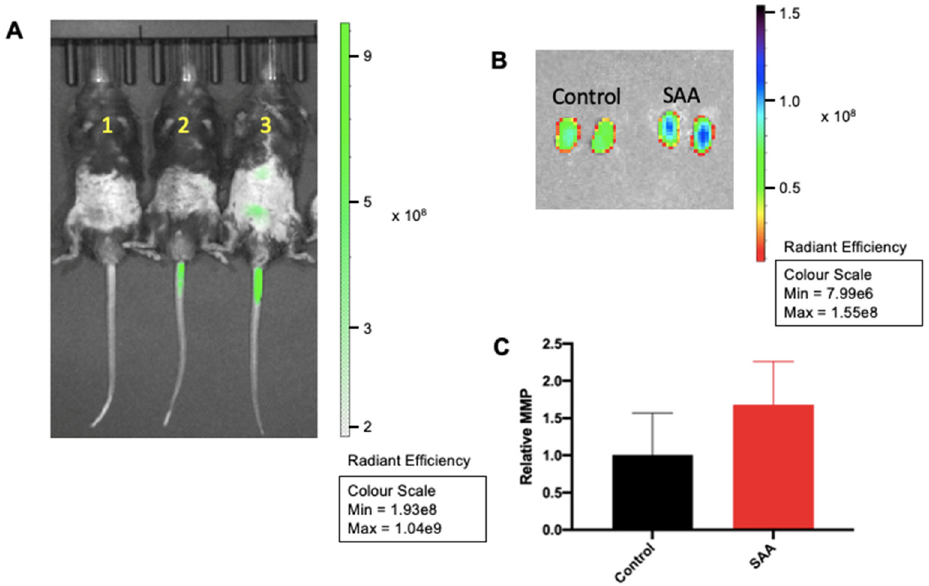
Figure 2. SAA administration activates MMPsense activity in vivo. Male ApoE − / − mice were randomly allocated to vehicle control (administered 100 µL PBS every 3 days for 2 weeks) and the SAA group (administered 12 µg SAA protein every 3 days for 2 weeks). MMPsense (2 nmol–150 uL) was injected via tail vein 24 h prior and animals were imaged using IVIS ® SpectrumCT (PerkinElmer). ( A ) In vivo mouse images after MMPsense injection (n = 3/group); mouse (1) control without MMP injection; (2) control with MMPsense injection and (3) SAA-treated with MMPsense injection. ( B ) Representative images of isolated kidneys from control and SAA group. After imaging, animals were sacrificed and organs harvested. Kidneys were isolated and imaged using IVIS ® SpectrumCT (PerkinElmer) for MMS sense activity. ( C ) MMPsense signal intensity in mice images was quantified using Living Image ® (PerkinElmer) data analysis software.